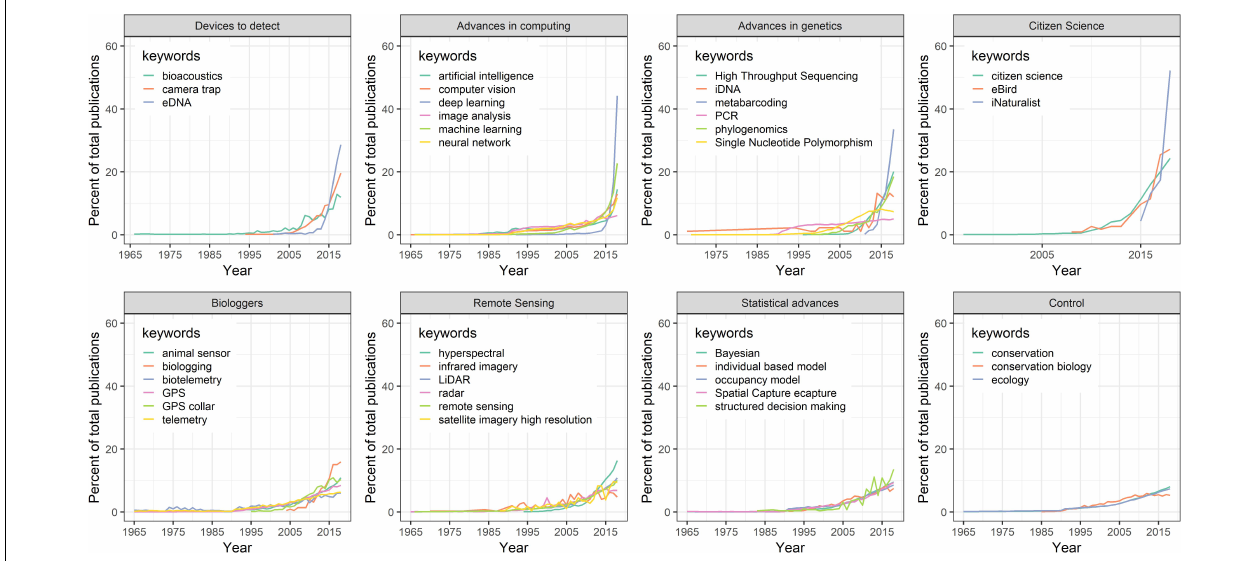
FIGURE 3 | Temporal change in the use of next-generation natural history keywords and control keywords in a Web of Science literature search from 1965 to 2018. Keywords are grouped by technological category. Percent of total publications calculated by dividing the number of publications in any given year by the total number of publications that contain the